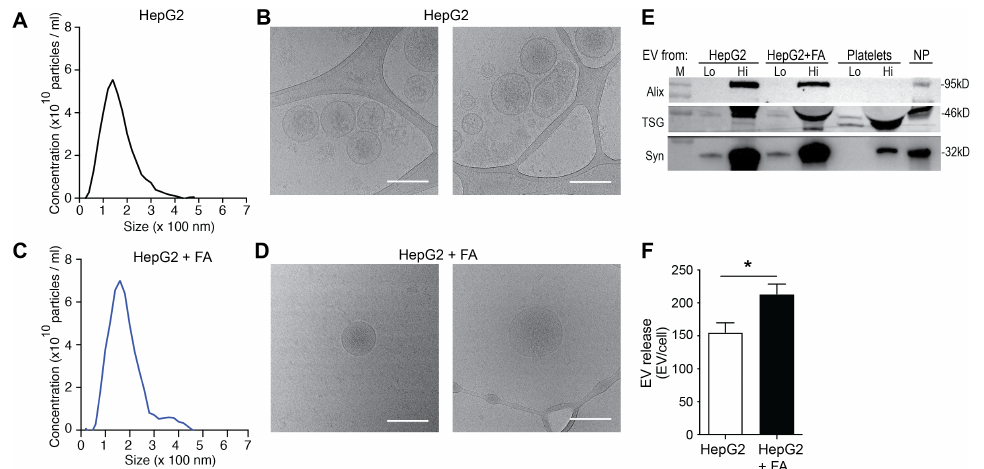
Figure 1. Treatment with fatty acids induces steatosis in HepG2 cells. NTA analysis ( A , C ) and representative electron micrographs (( B , D ) at 53,000 × magnification) of EVs in media of HepG2 cells collected under resting conditions ( A , B ) or after treatment with fatty acids (FA) for 24 h ( C , D ). Scale bars: 200 nm. ( E ) Western blot of the EV markers Alix, TSG101 and Syntenin in EVs isolated from HepG2 cells with or without FA treatment and from platelets (Lo: 10 7 , Hi: 10 8 EV) or normal pooled plasma (NP, 6 × 10 7 EV). ( F ) Expression of EV release as number of EVs per cell. * p < 0.05 with 2-tailed t -test, mean ± SEM (n =